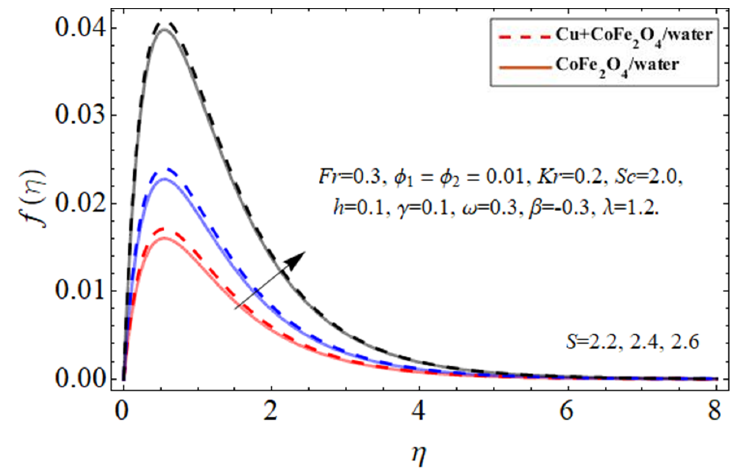
( ) η ( ) η f f against disk fluctuation term S . against disk fluctuation term S .